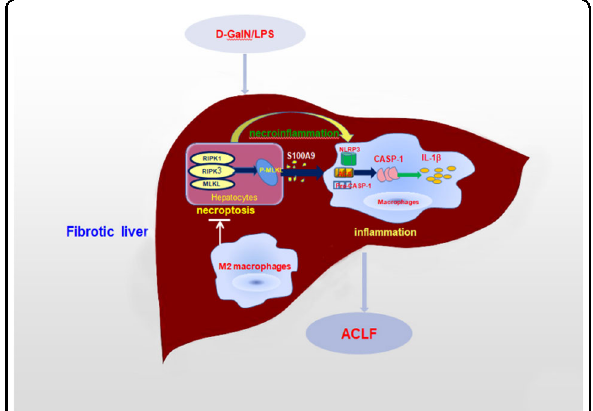
Fig. 7 An illustration of the hepatoprotective role of M2-like macrophages through inhibiting necroptosis-S100A9- necroin fl ammation axis in ACLF. M2-like macrophages in the fi brotic mice inhibit necroptosis signaling and S100A9 expression triggered by acute insult, and further suppress necroptosis- and S100A9-dependent NLRP3 in fl ammasome activation and ensuing necroin fl ammation, therefore promoting injury resistance occurred in